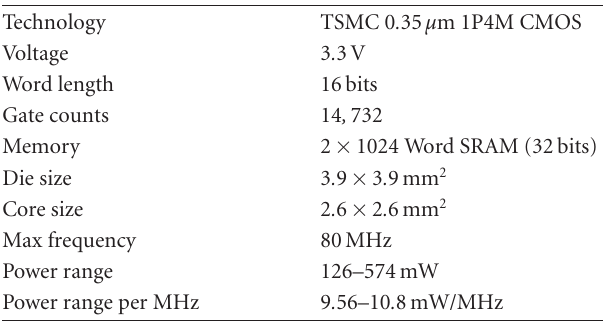
Table 3: Implementation results of the variable-length FFT proces- sor.